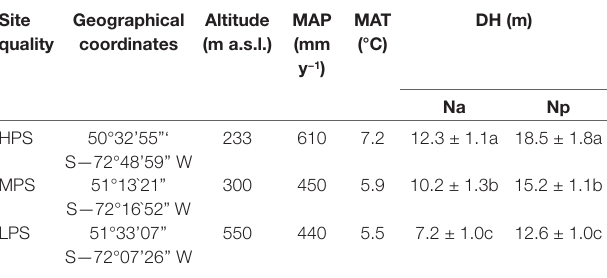
TaBlE 1 | Main characteristics of Nothofagus forests located in three different sites of southern Patagonia. Site Geographical quality